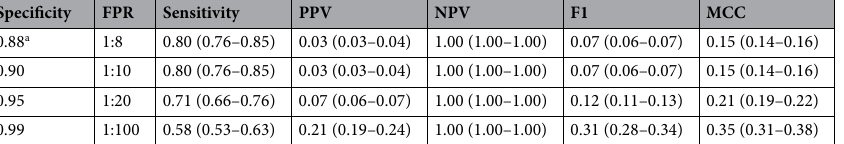
Table 4. Combined model performance at fixed specificity cut points. All metrics are reported as metric (95% CI) except for false-positive rates, which are reported as ratios. FPR false positive rate, PPV positive predictive value, NPV negative predictive value, MCC Matthew’s correlation coefficient. a Youden’s